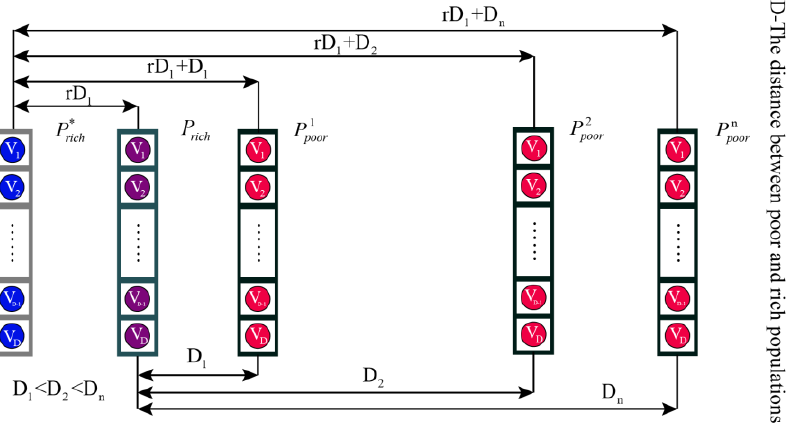
Figure 4. Position distribution for the rich and poor